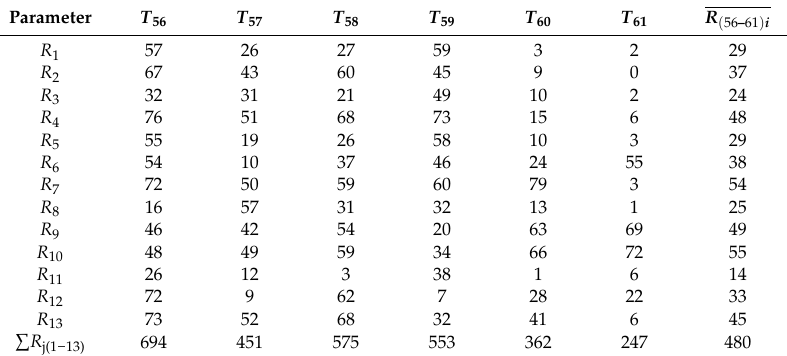
Table A22. Ranking of T j territories on land activity, Ural Federal District.